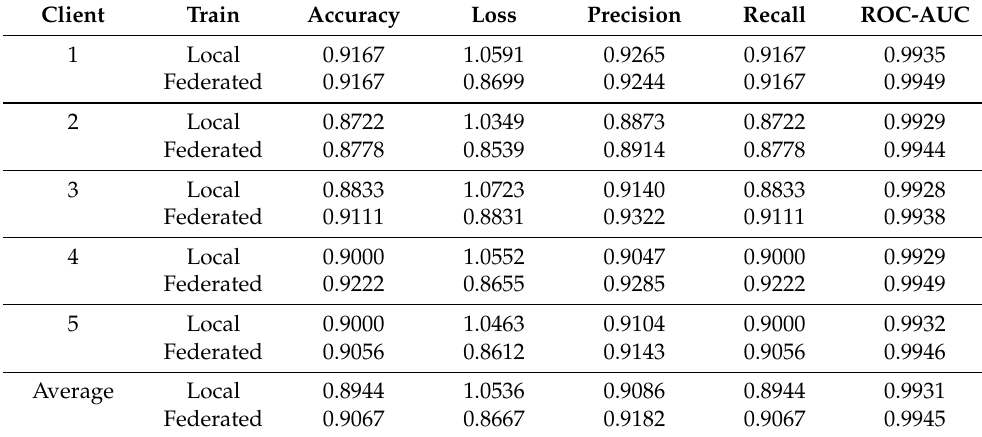
Table 3. Model training results for scenario 1.